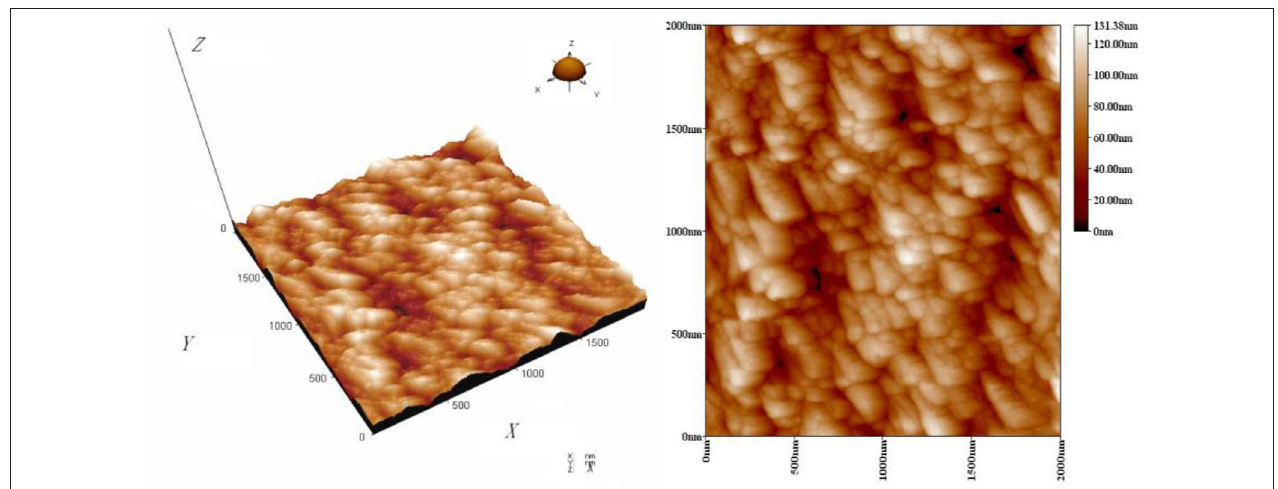
FIGURE 5 | The AFM patterns of InN films at N 2 flux with 80